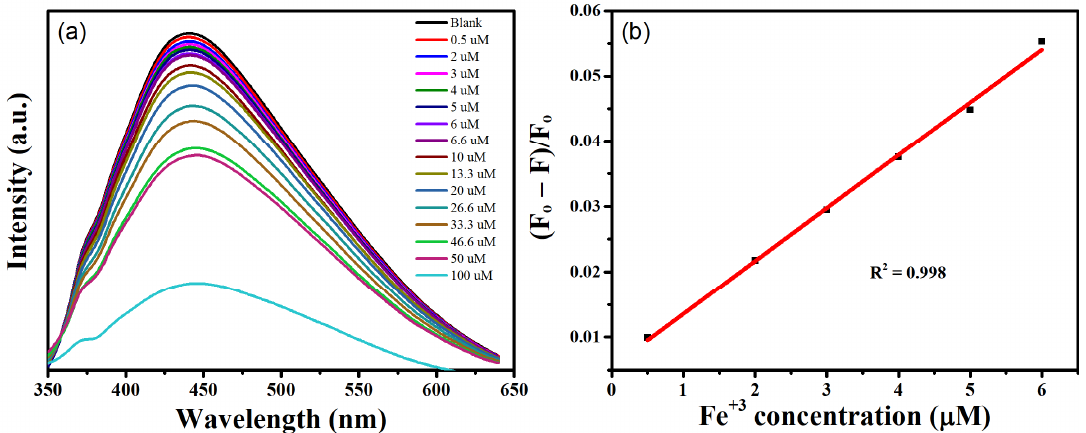
Figure 9. ( a ) Fluorescence spectra of GQDs (10 mg mL − 1 ) with Fe 3+ concentrations ranging from 0 to 100 µM, with an excitation wavelength of 340 nm and ( b ) Linear regression plot of fluorescence intensity and Fe 3+ concentration in low concentration range of 0.5–6 µM.